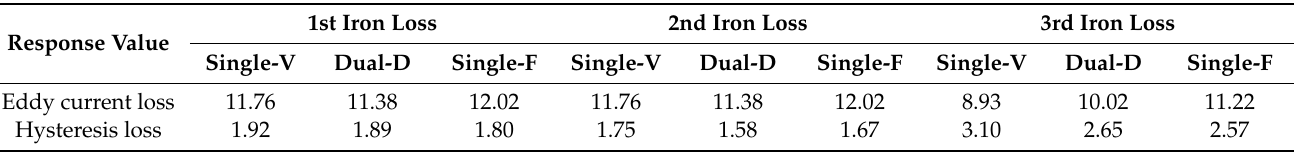
Table 5. Comparison of three rotor structure iron losses in stator using three different calculation method at 6540 rpm and 24 A phase current.